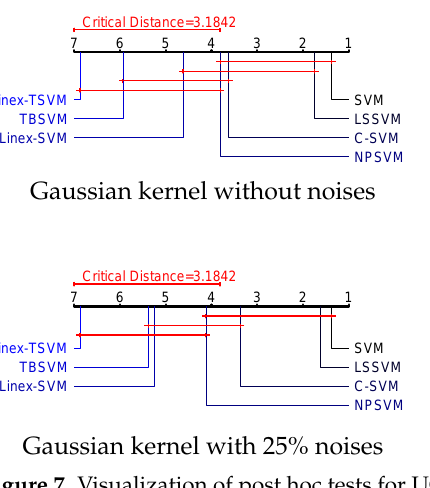
Figure 7. Visualization of post hoc tests for UCI